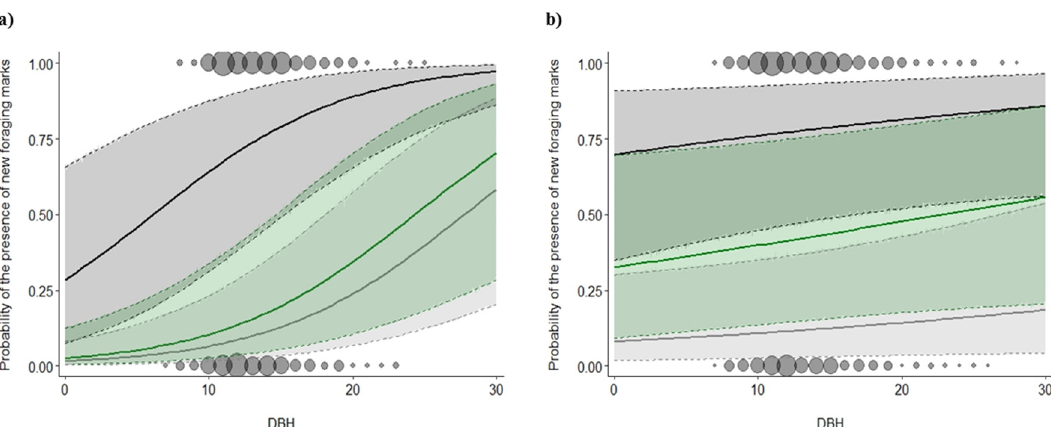
Figure 6. Projected probability of the presence of new woodpecker foraging marks ( ± 95% CI) on girdled trees sampled in October 2016, based on the DBH of dead (black lines), dying (green lines), and live trees (gray lines) for ( a ) uniform and ( b ) clustered treatments. Gray dots represent the distribution of raw data; the size of dots is related to the number of observations; darker gray dots are superimposed data.